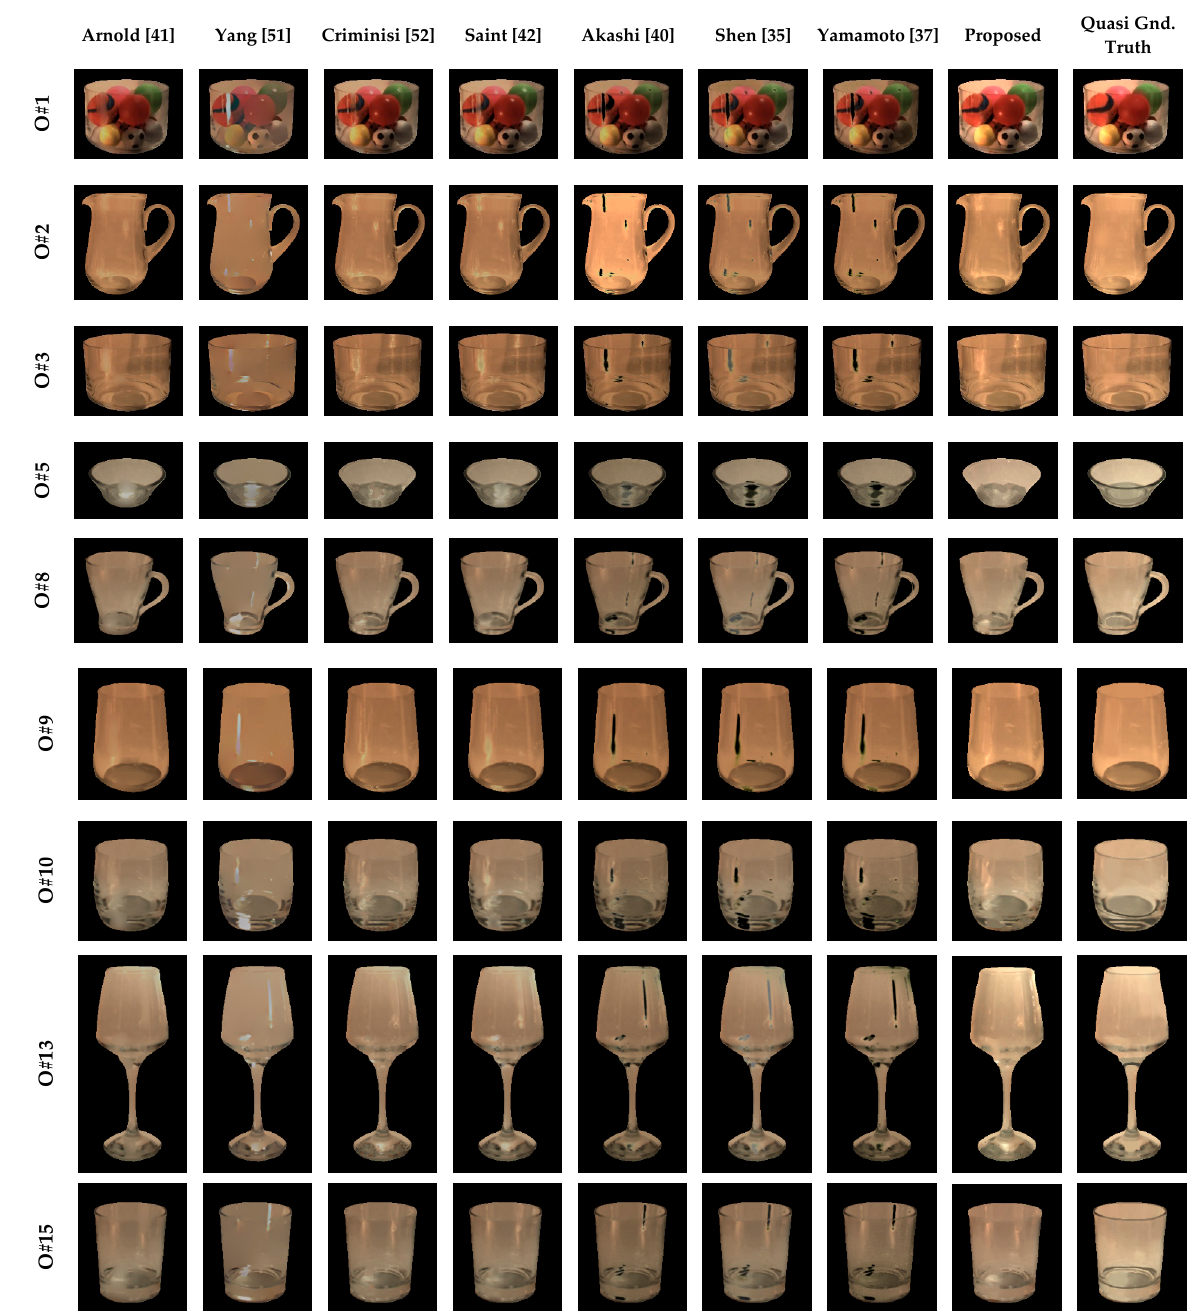
Figure 18. Comparison of SRI accuracies of different methods for sample objects in MSPLFI dataset.